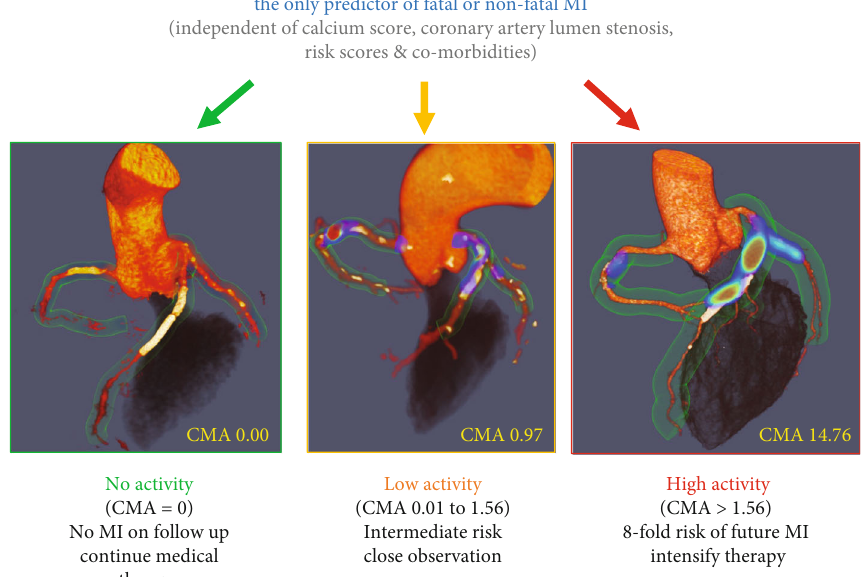
Figure 4: 18 F-sodium fl uoride positron emission tomography as a marker of disease activity in the coronary arteries is a predictor of fatal or nonfatal myocardial infarction (MI) in patients with established coronary artery disease. 18 F-NaF PET can be used to measure disease activity across the coronary vasculature and to stratify patients into those with no, low, and high disease activity. Patients with high disease activity (coronary microcalci fi cation activity ð CMA Þ > 1 : 56 ) demonstrate a > 7-fold risk of myocardial infarction. These patients might therefore be suitable for advanced medical therapies including PCSK9 or interleukin 1-beta inhibition, with 18 F-NaF PET used for targeting these expensive drugs to patients at greatest risk. Patients without coronary 18 F-NaF uptake ( CMA = 0 ) have an excellent prognosis with no myocardial infarctions observed during follow-up despite advanced coronary artery disease. In these patients with dormant coronary artery disease (a third of the population studied), further intensi fi cation of medical therapy might not be warranted, nor might they bene fi t on prognostic grounds from complex revascularization such as multivessel percutaneous intervention or coronary artery bypass grafting. Reprinted from Kwiecinski et al. [71], with permission from